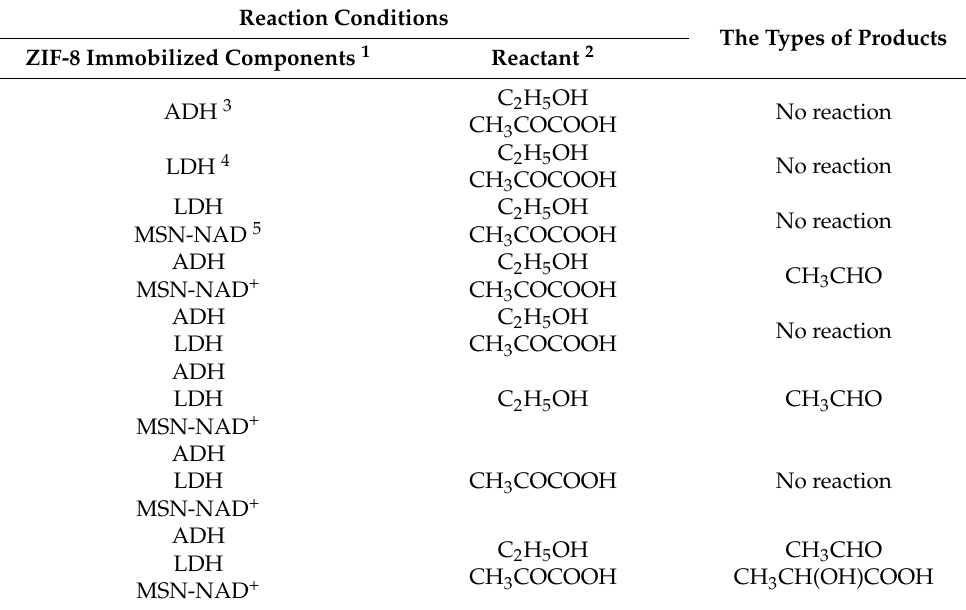
Table 1. Conditions of the multi-enzyme cascade reaction and the types of